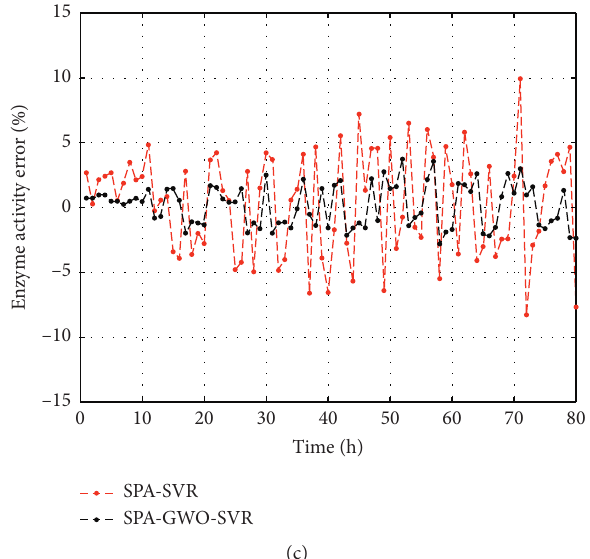
Figure 6: Comparisons of the predicted error curve. (a) Prediction error of cell concentration. (b) Prediction error of matrix concentration. (c) Prediction error of enzyme